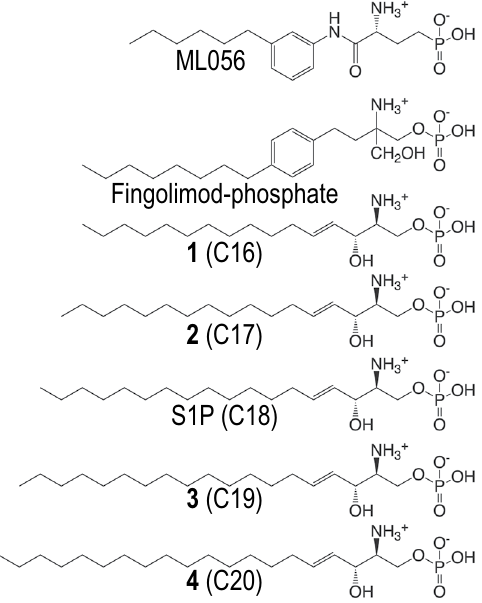
Figure 1. Structure of ML056, Fingolimod-phosphate, S1P and synthetic derivatives 1–4 of variable chain